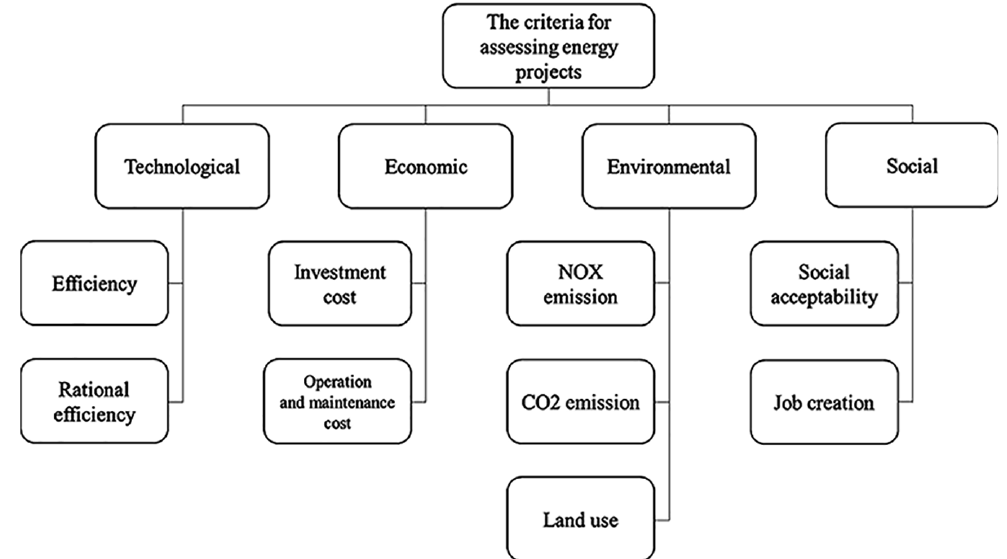
Figure 2. Hierarchical chart of criteria and sub-criteria